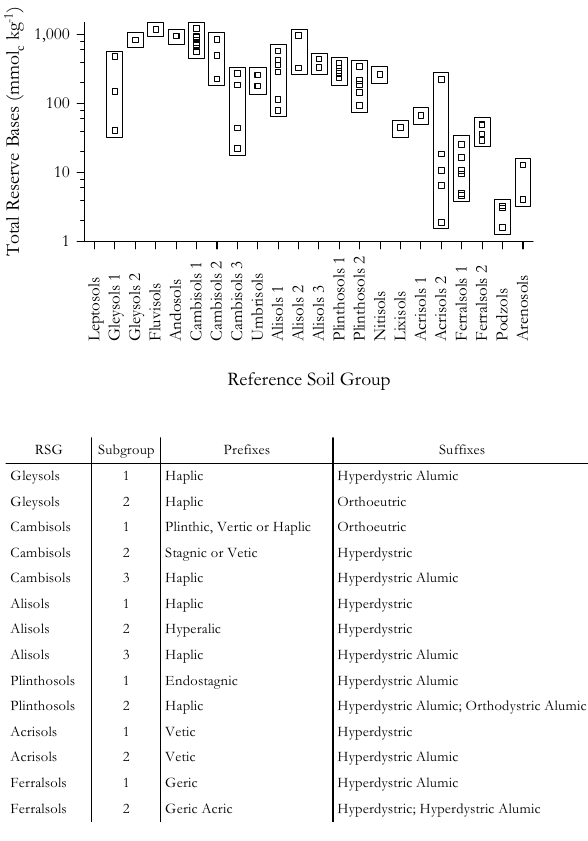
Fig. 21. Relationship between the axis of soil development and the chemically based weathering index Total Reserve Bases ( 6 RB ) . Details for World Reference Base lower level classification are also